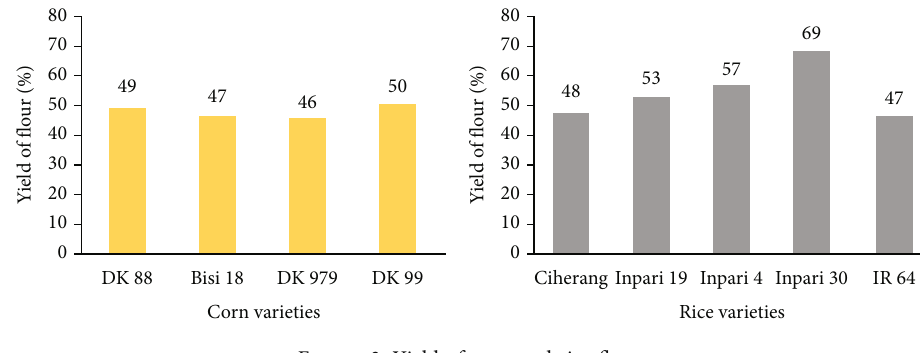
Figure 3: Yield of corn and rice fl our.